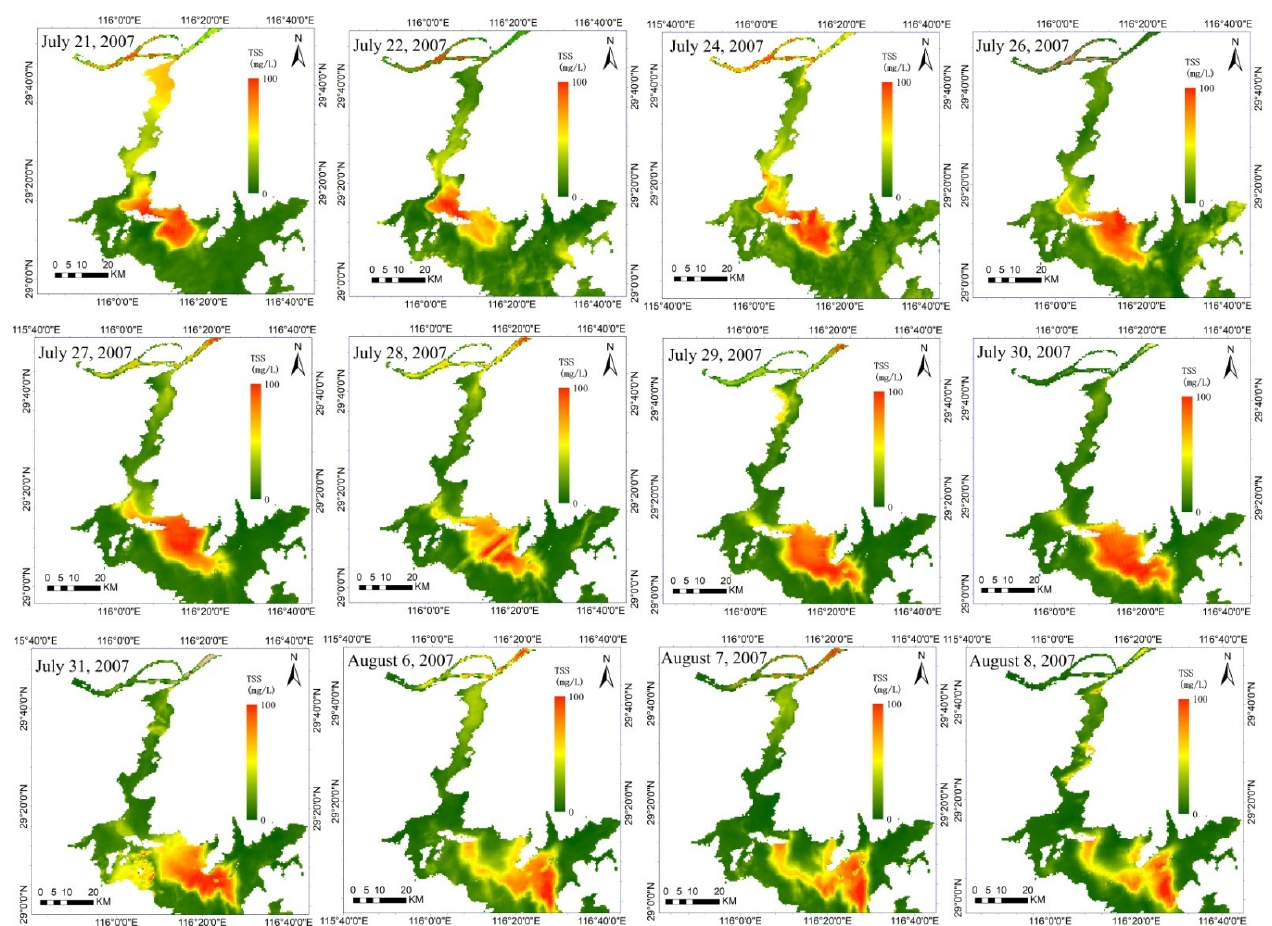
Figure 7. The spatial-temporal distribution of ρ (cid:2904)(cid:2903)(cid:2903) ρ in Poyang Lake during the period of a BRL from July to August 2007.